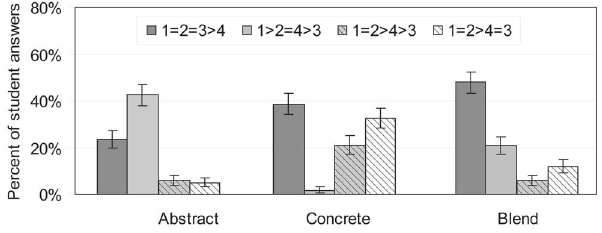
FIG. 12. Student answers to the sound waves quiz question 2 according to experimental group. The correct answer is the left- most dark gray bar (cid:1) 1=2=3 (cid:1) 4 (cid:2) .